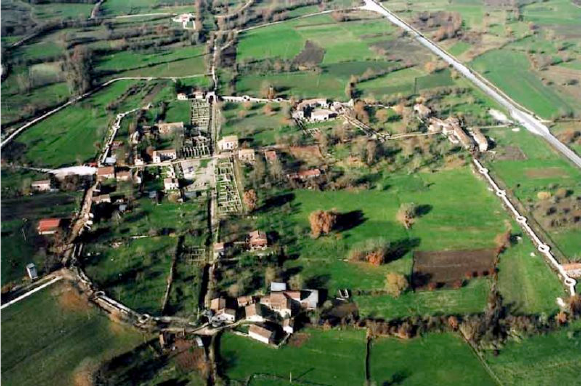
Figure 2. The archaeological site of Saepinum